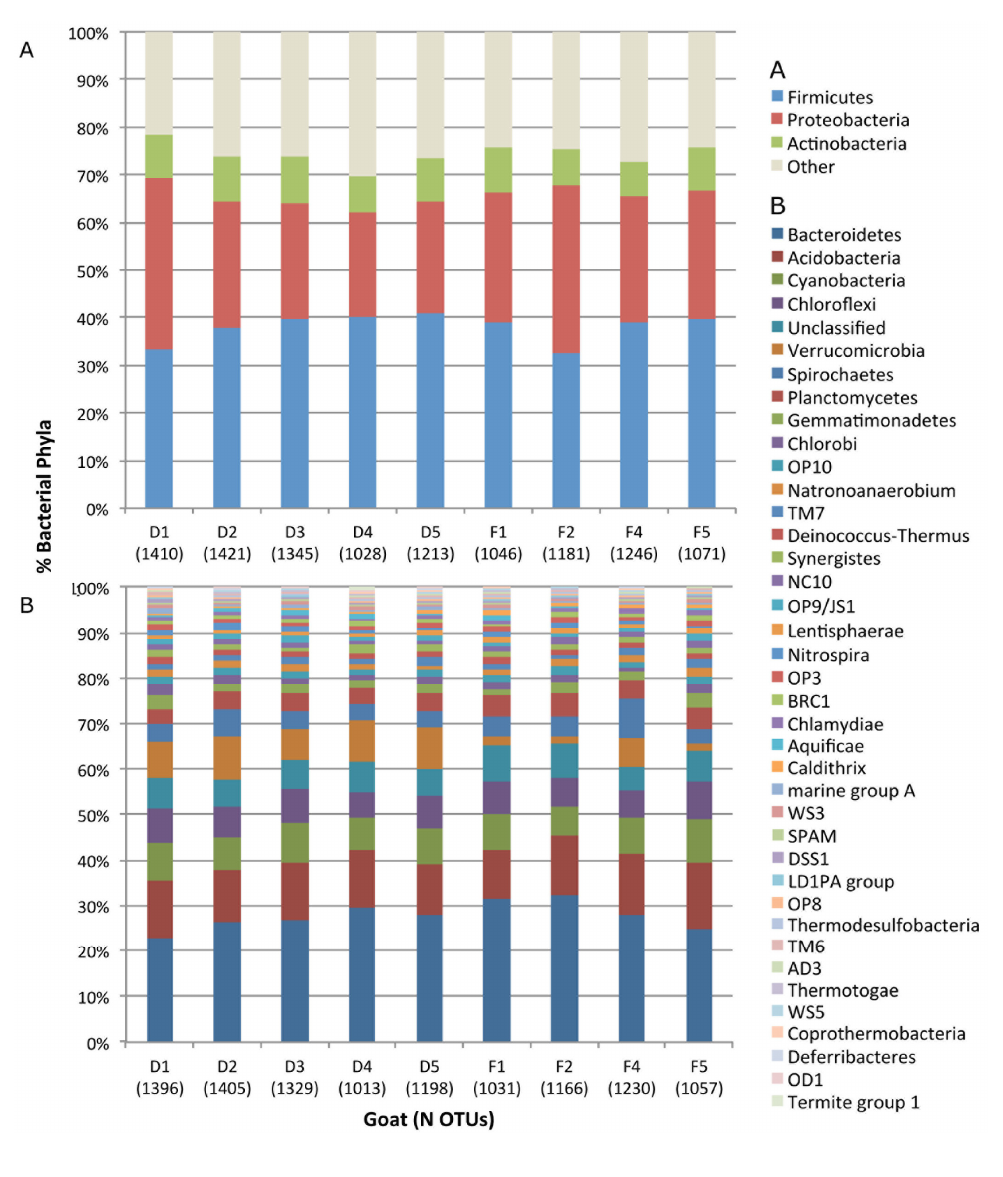
Figure 1. Richness distribution of the 1,982 OTUs in 42 bacterial phyla among the feces of five domestic (D) and four feral (F) goats. ( A ) Abundant phyla. ( B ) Phyla less represented ( i.e. ,